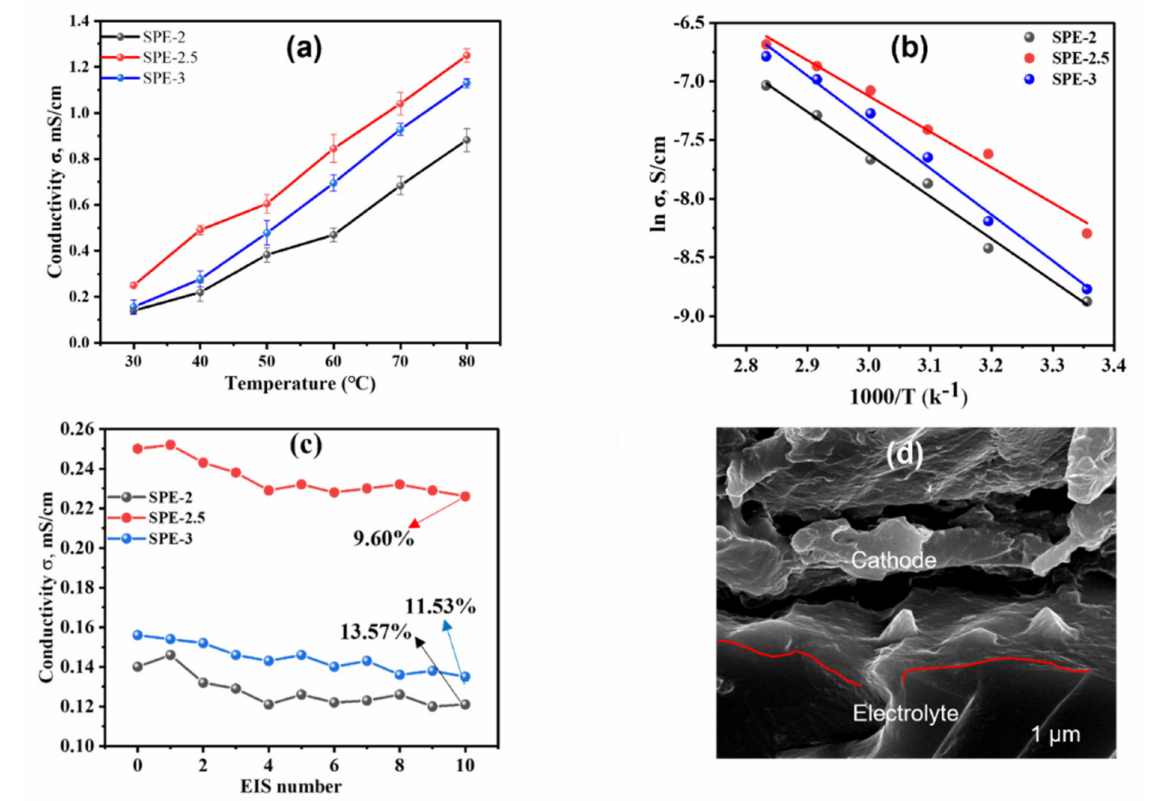
Figure 5. Plots of conductivity vs. temperature ( a ) and ln (Li + conductivity) vs. the inverse of absolute temperature ( b ) of SPEs. ( c ) Variation of the conductivity of SPEs with repetitive EIS scanning for SPE-2, SPE-2.5, and SPE-3, at 25 ◦ C and open circuit condition. ( d ) Cross-sectional FE-SEM image after 50 cycles from dummy cell of